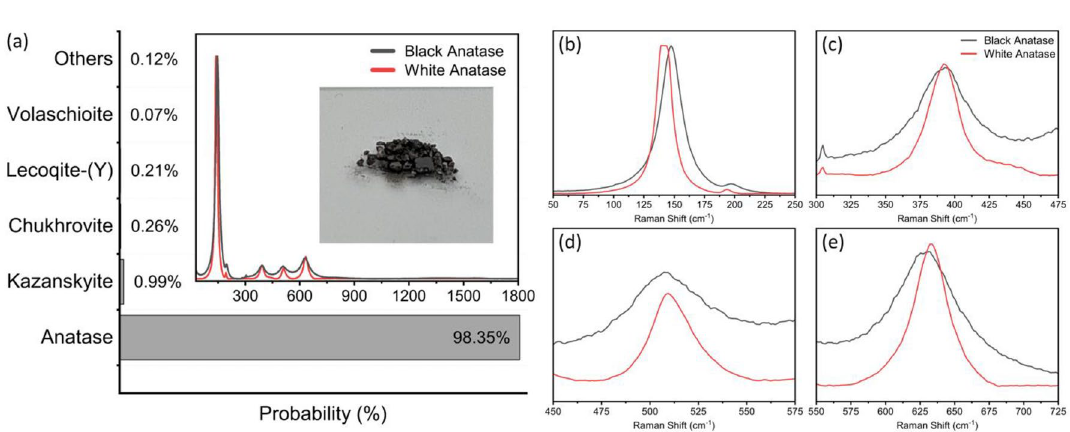
Figure 4. ( a ) The figure shows the response of the model to our synthesized anatase TiO 2 sample. The model can identify the presence of anatase with utmost certainty. ( b ) The figure shows the response of the model to our rutile TiO 2 sample. The model correctly identifies Rutile with a high degree of confidence. The Raman spectrum of the mineral and the image of the sample are presented to provide adequate context. The bar chart shows the Top-5 predictions and the other predictions are combined as others.